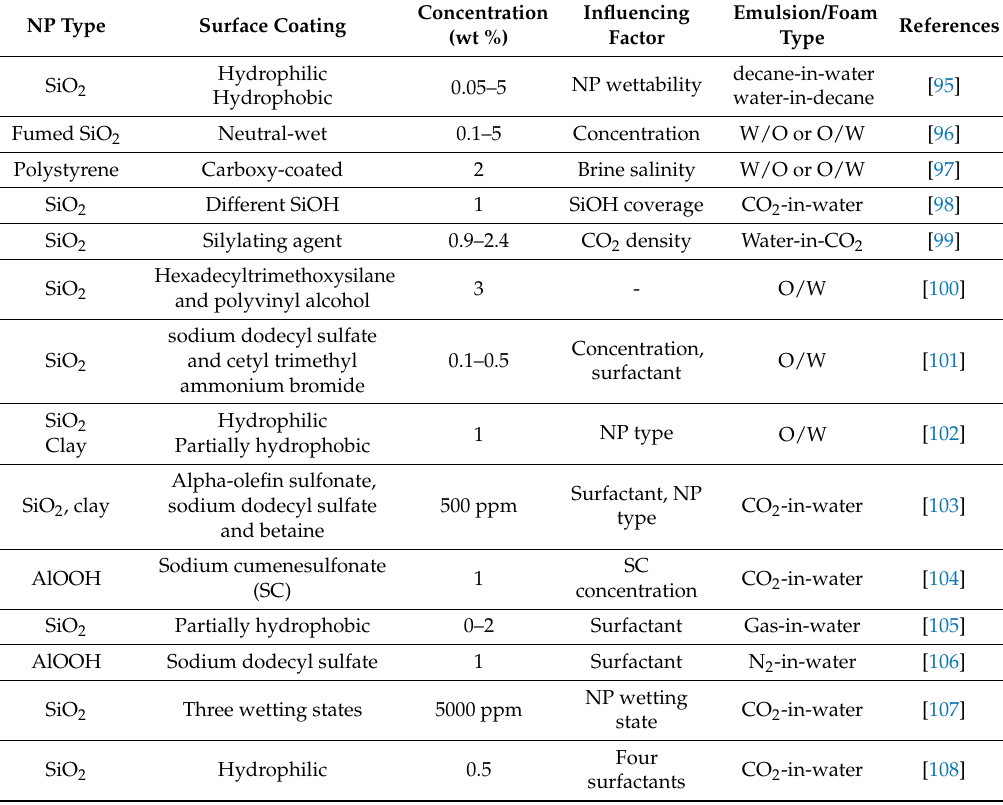
Table 3. Summary of the reported experimental studies on nanoemulsion and